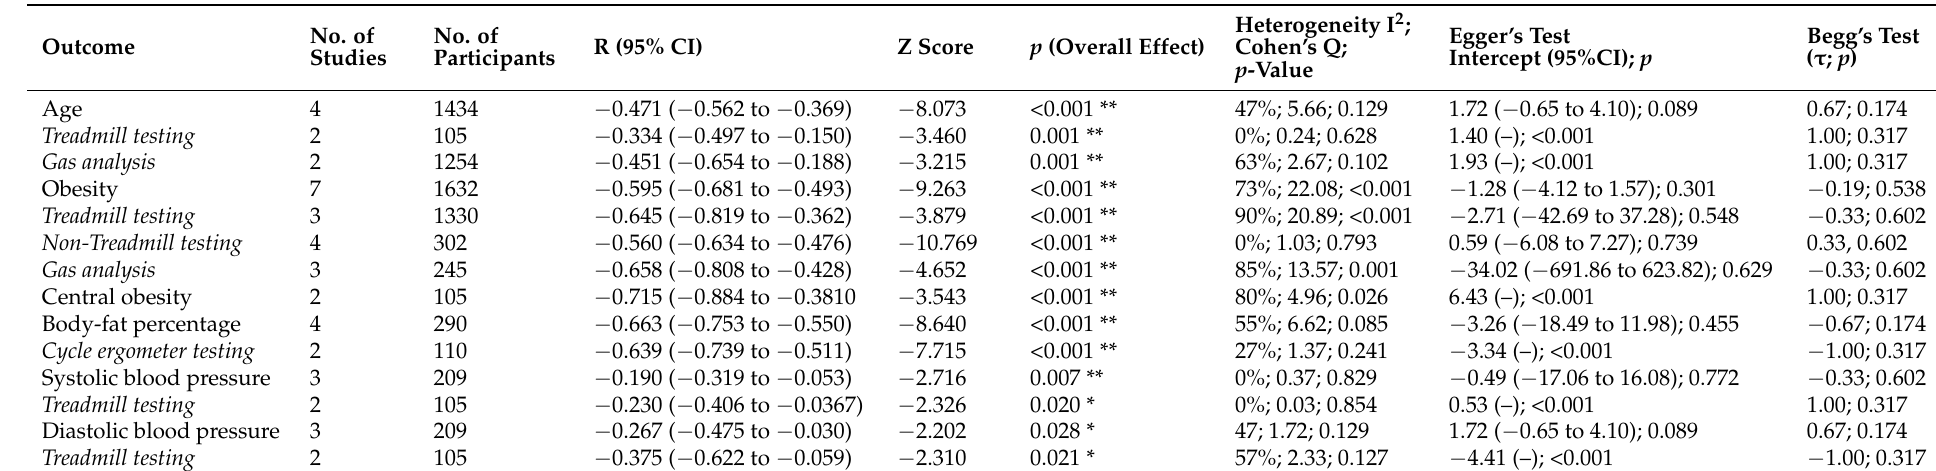
Table 2. The correlations between age, obesity, and blood pressure and cardiorespiratory